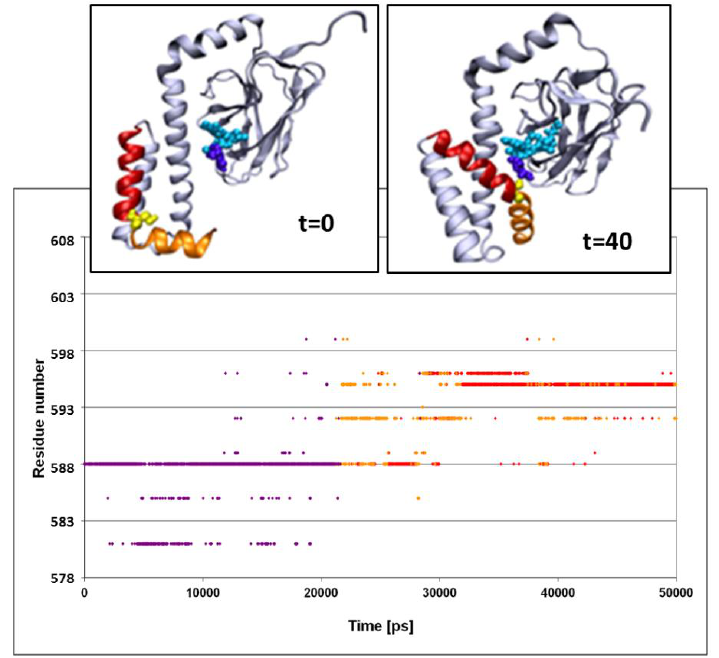
Figure 3. Sites of interactions of the lid with the peptide. Spatiotemporal analysis of the data from the SBD NR+ simulation, characterizing the interacting residues between the lid helices and the bound peptide. The Y axis represents the amino acid of helices D and E. Red and orange dots stand for distances smaller than 3 Å or between 3 and 6 Å, respectively. Purple indicates distances greater than 6 Å. Insets: Snapshots presenting the structure of SBD at the end of the simulation (right inset) compared to the one at the starting point (left inset). A cartoon diagram of the DnaK-SBD (grey), emphasizing helices D and E (red and orange, respectively) and Ser 595 in CPK (yellow). The NR peptide is presented in CPK, colored in cyan, except for the Asn 1